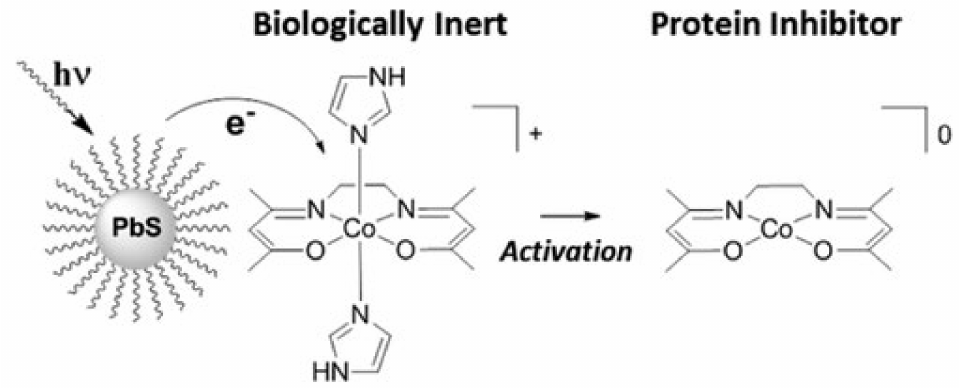
Figure 14. Photoinduced electron transfer (PET) process between Co(III) Schiff base complex and colloidal PbS quantum dots. Reprinted with permission from Ref. [86]. Copyright 2013, American Chemical